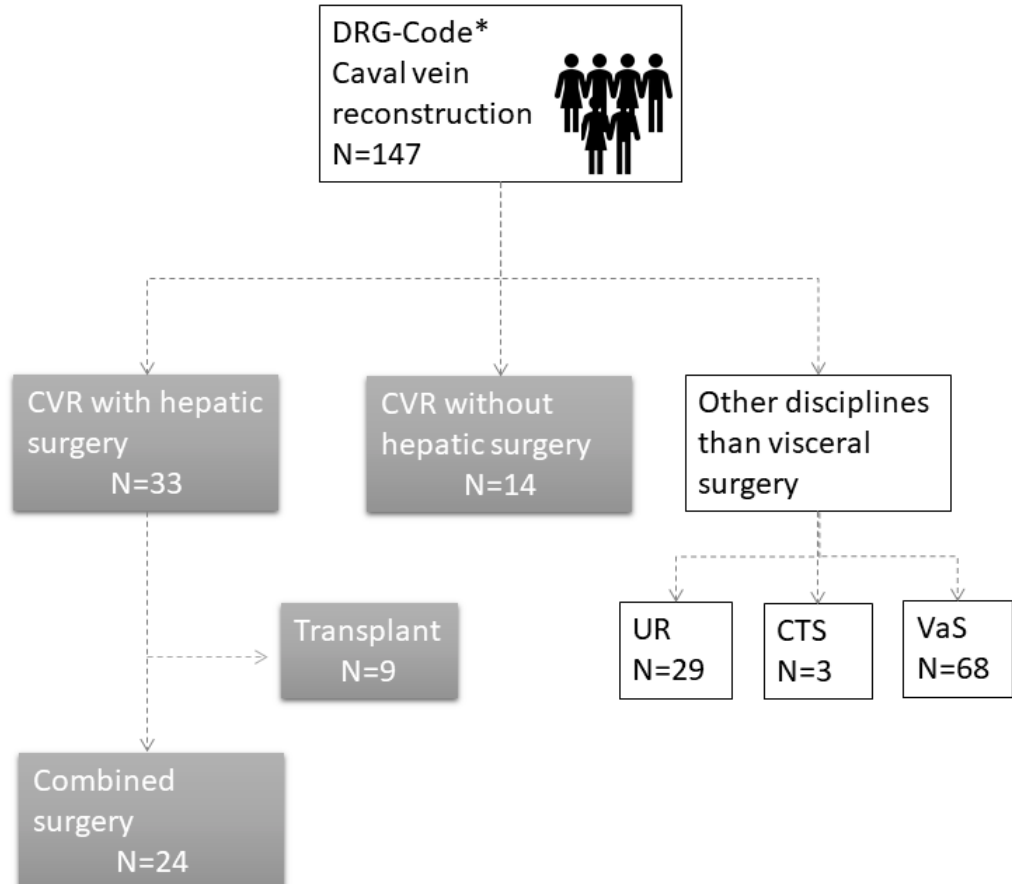
Figure 1. Flow diagram displaying the criteria for the inclusion in the study. In 147, patients the DRG code for ICV reconstruction was used. One hundred patients were operated by other disciplines and 14 received a reconstruction without hepatic surgery. Of the remaining 33 patients, 9 underwent liver transplantation. This resulted in a final sample size of 24 patients for combined surgical resections of the ICV and hepatic surgery. Abbreviations: CVR, caval vein reconstruction; UR, urology; VaS, vascular surgery; CTS, cardiothoracic surgery.